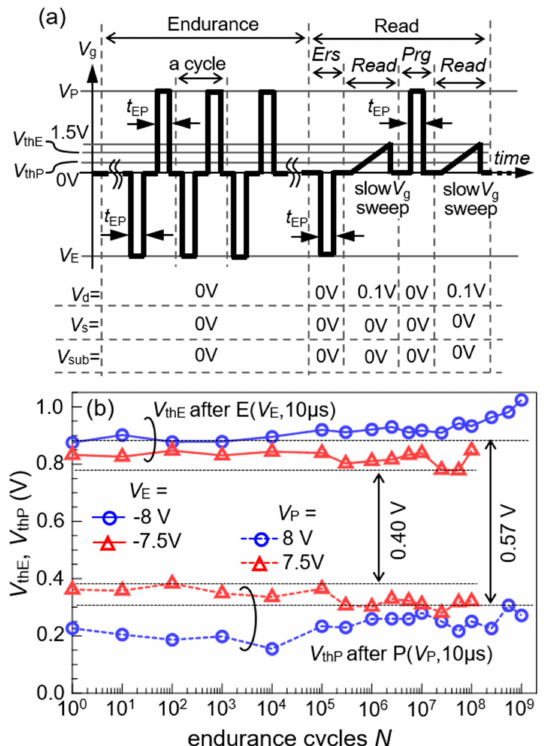
Figure 7. Endurance of a FeFET with L ch = 85 nm. The channel width was W = 80 µ m. ( a ) The measurement procedures of applying endurance cycles and reading V thE and V thP . ( b ) Endurances were measured up to N = 10 8 cycles for 7.5 V V g pulse heights and N = 10 9 cycles for 8